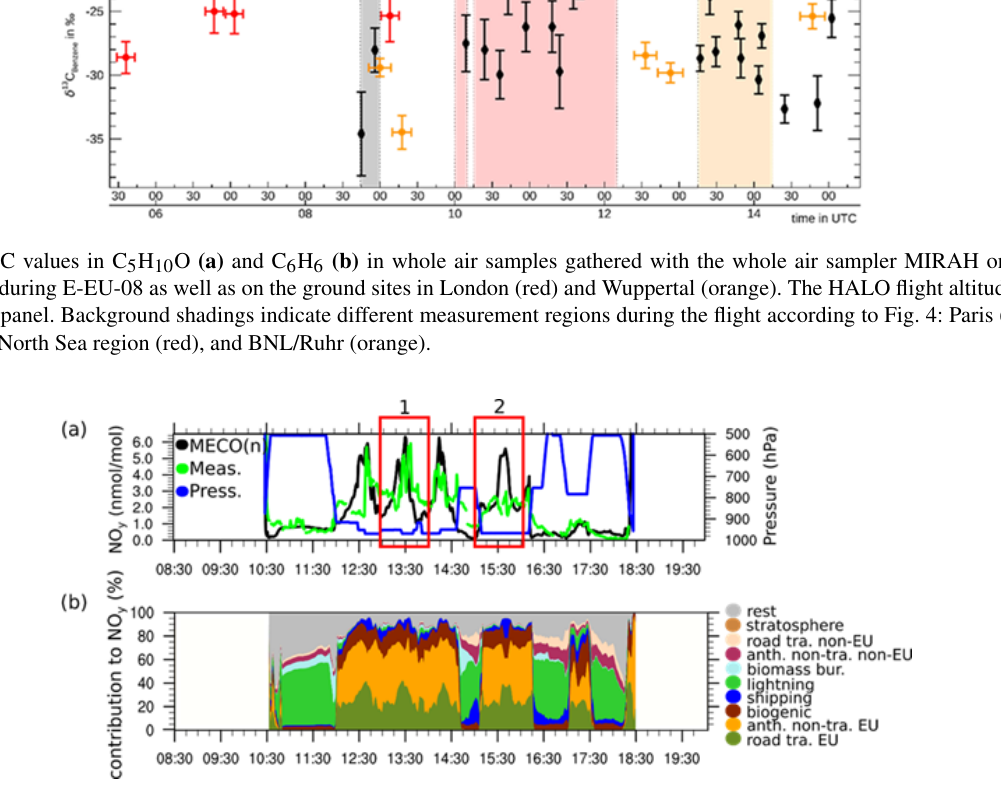
Figure 37. (a) NO y mixing ratios measured (green) and simulated by the MECO(n) model (black) for E-EU-05 on 17 July 2017. The blue line denotes the pressure altitude of the aircraft (right axis). (b) Relative contributions of different emission sectors to the NO y mixing ratios simulated by MECO(n). Note that the NO y measurements were averaged to 60s to fit the MECO(n) temporal